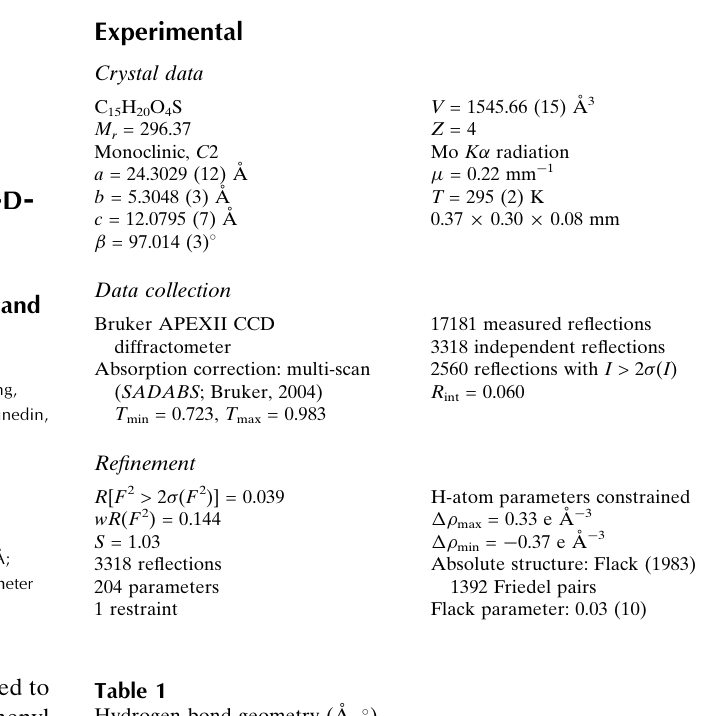
Hydrogen-bond geometry (A˚ , (cid:2)